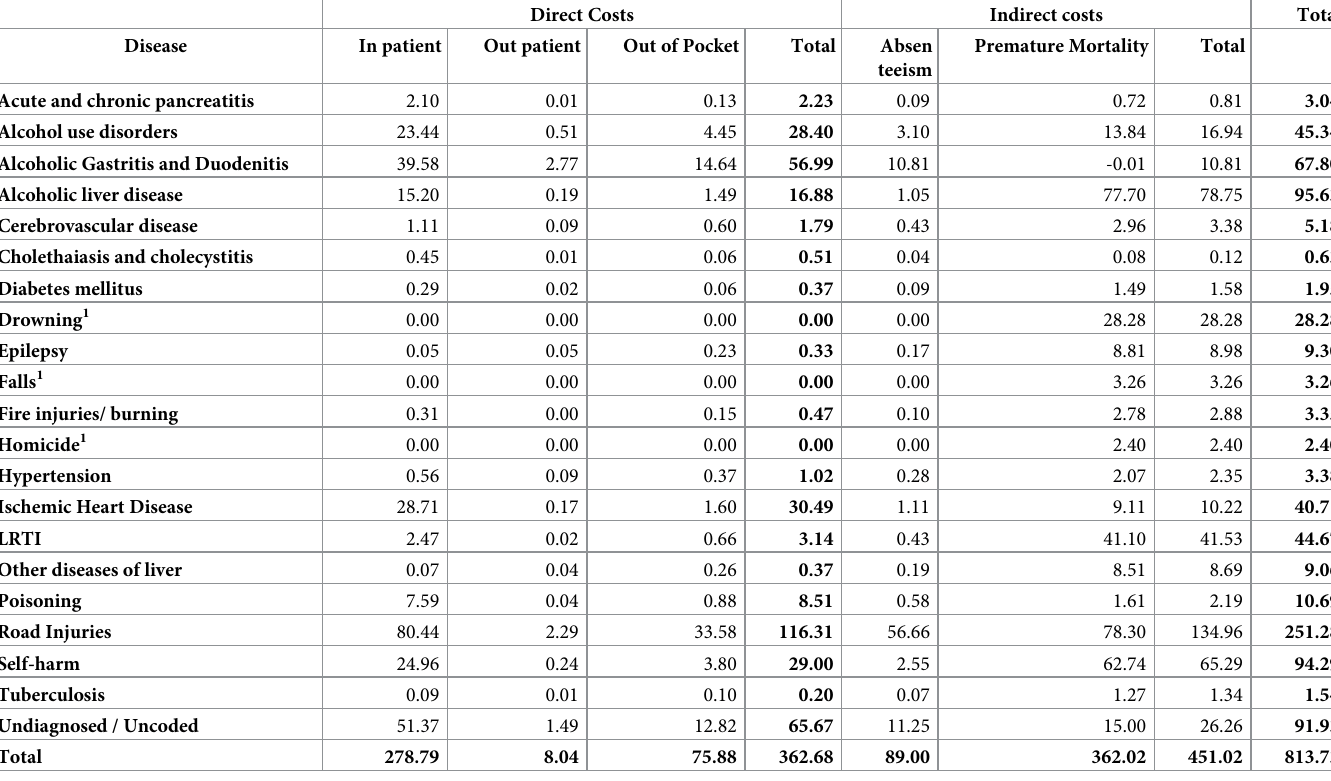
Table 4. Direct, indirect and total economic costs of alcohol related conditions other than cancers in Sri Lanka 2105 in USD